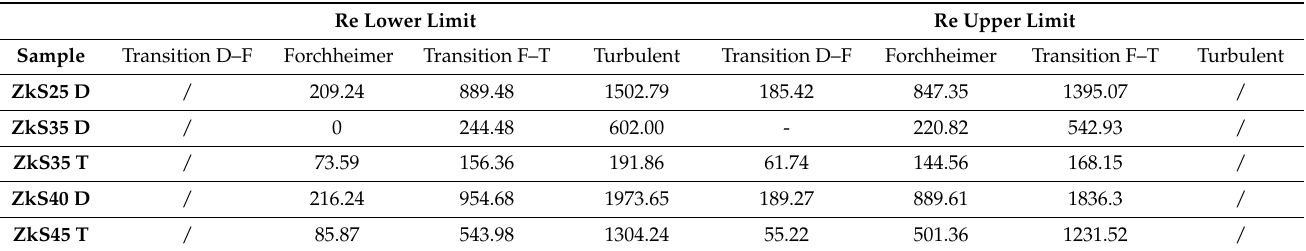
Table 6. Air flow regime boundaries of ESR foams.